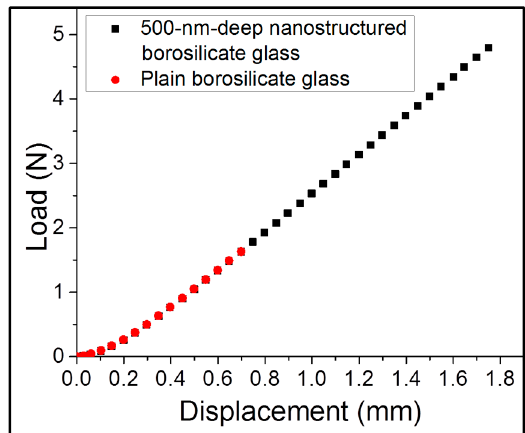
Figure 4. Load-displacement curve for plain borosilicate glass and 500-nm-deep nanostructured borosilicate glass. The almost similar slope for both plain and 500-nm-deep nanostructured confirms unchanged bulk properties after nanostructure fabrication.